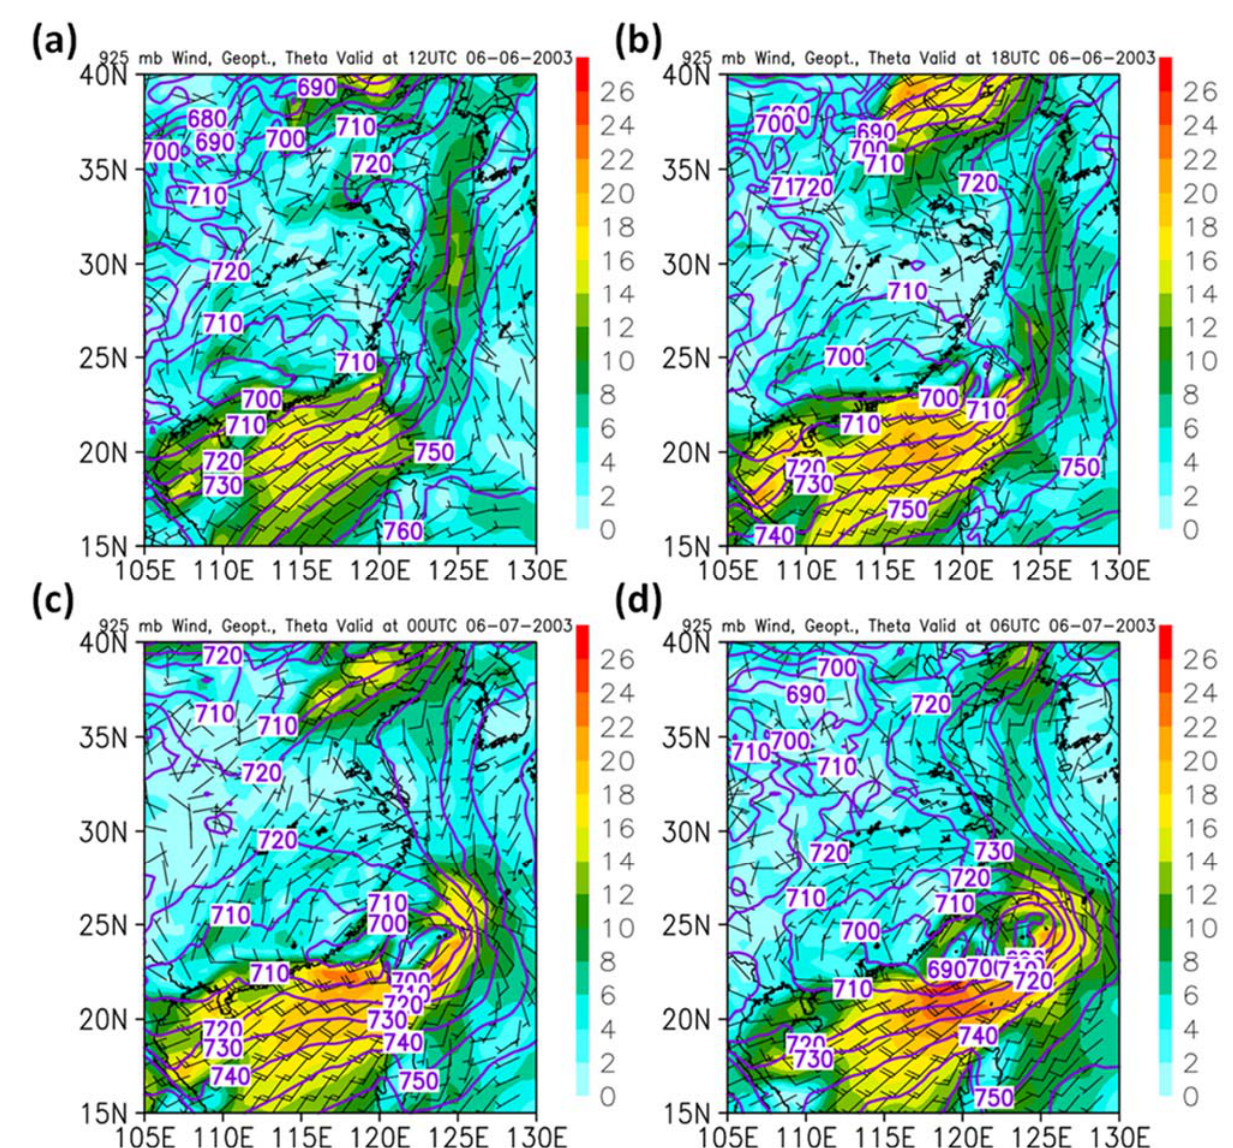
Figure 2. The CFSR geopotential height (gpm, contoured), wind speed ( V; m s − 1 , shaded), and winds (m s − 1 ) (full barb and half barb represent 10 and 5 m s − 1 , respectively) at 925 hPa at ( a ) 1200 UTC (2000 LT) 6 June; ( b ) 1800 UTC 6 June (0200 LT 7 June); ( c ) 0000 UTC (0800 LT) 7 June; and ( d ) 0600 UTC (1400 LT) 7 June 2003.